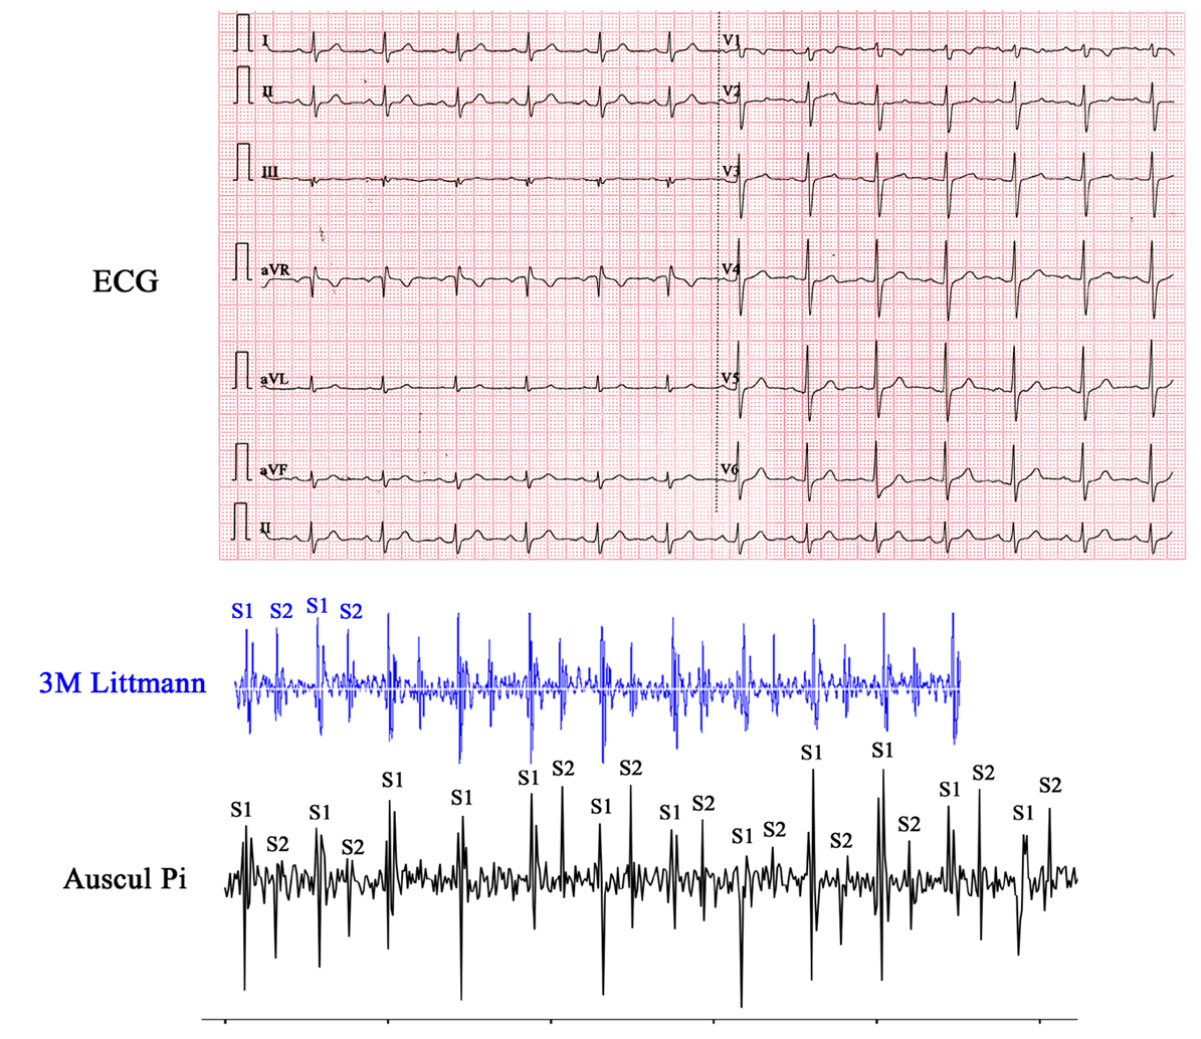
Figure 7. Electrocardiogram and phonocardiograms of healthy volunteer 9 generated by the 3M Littmann stethoscope and Auscul Pi, showing